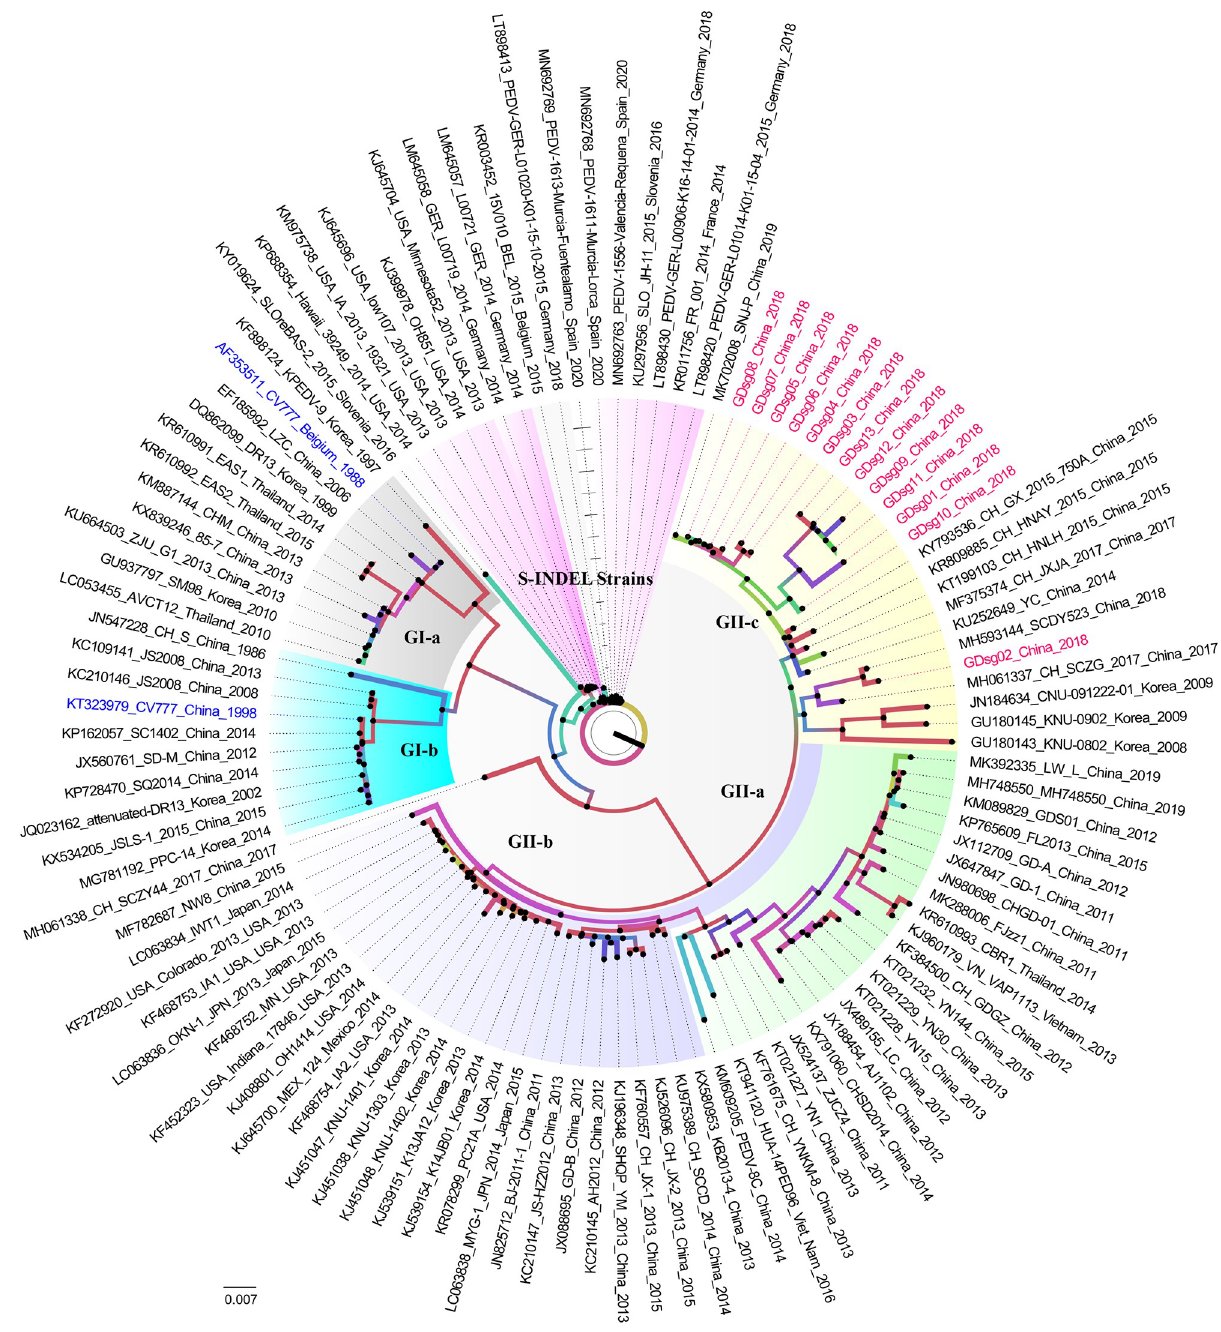
Fig 1. Phylogenetic analysis of full-length S gene of 13 PEDV strains collected in this study. MAFFT (Multiple Alignment using Fast Fourier Transform) in the UGENE software was used to align 98 PEDV reference strains with 13 PEDV strains (Version 36.0). With IQ-TREE, the phylogenetic tree was built using the maximum likelihood (ML) method with 1,000 bootstrap replicates (Version 1.6.12). PEDV ’s S gene PEDV was divided into six categories: GI-a (light grey), GI-b (blue), GII-a (light green), GII-b (light cyan), and GII-c (light cyan) (light yellow). The CV777 reference strains are highlighted in blue, while the 13 strains reported in this study are highlighted in red. Nucleotide substitutions per site are indicated by a 0.007 bar.